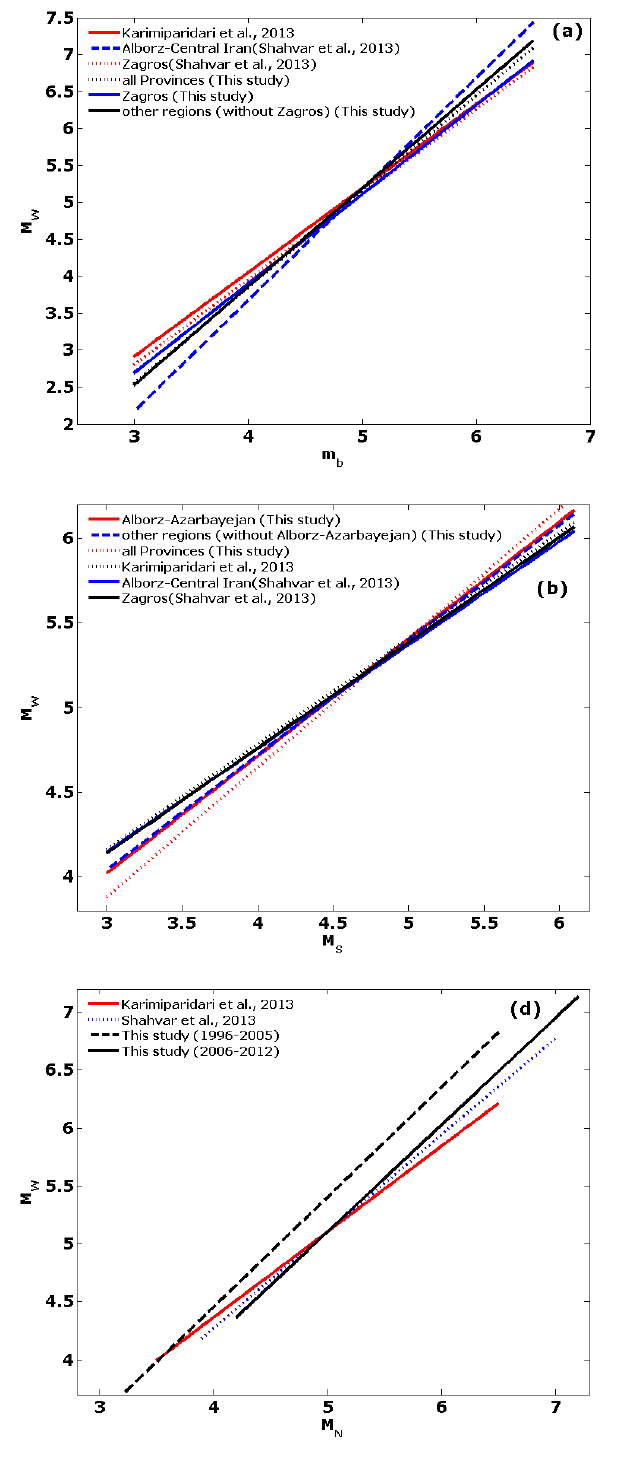
Figure 10. Comparison of magnitude conversion relations, this study and the other